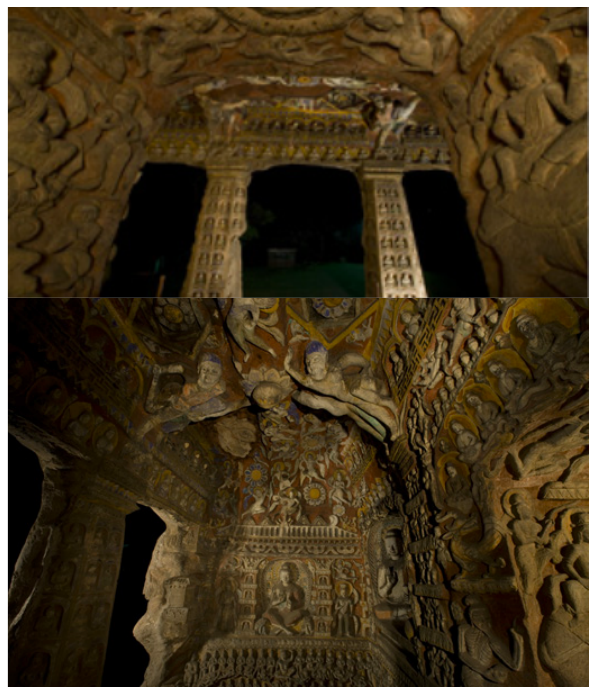
Figure 1. Cave No.9 Yungang